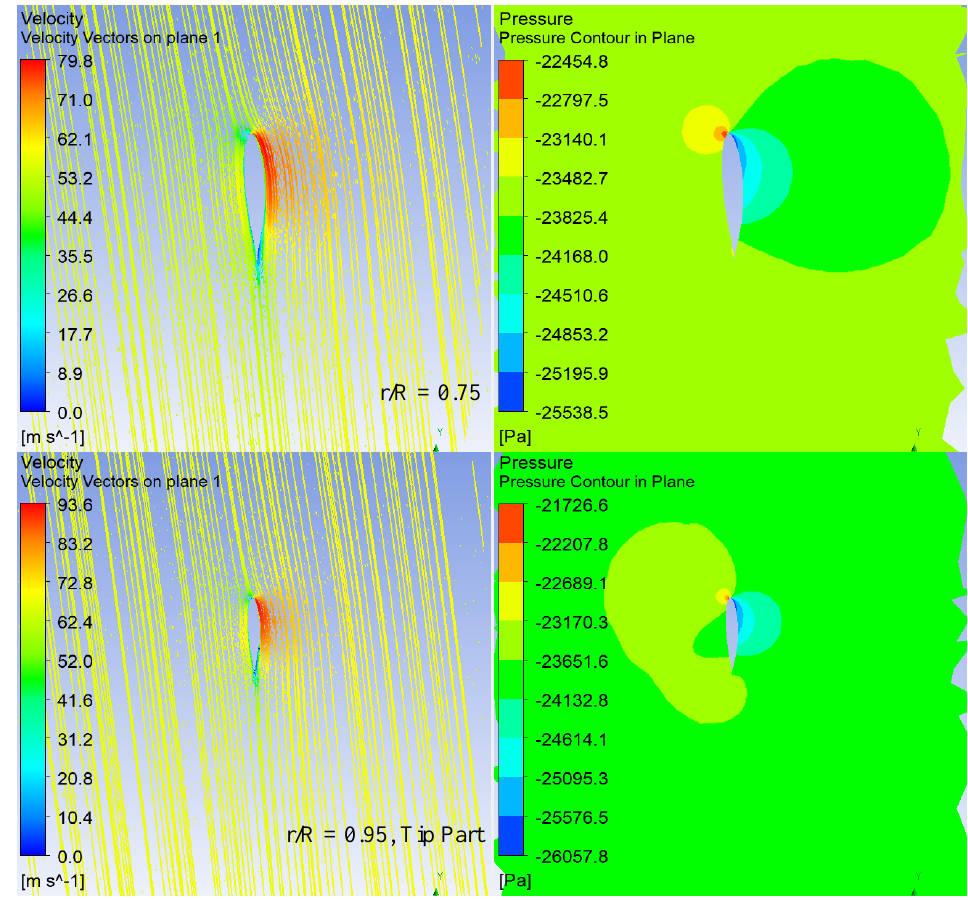
Figure 4. Velocity streamlines and pressure contour of the blade sections at a different radial positions from the root to the tip.